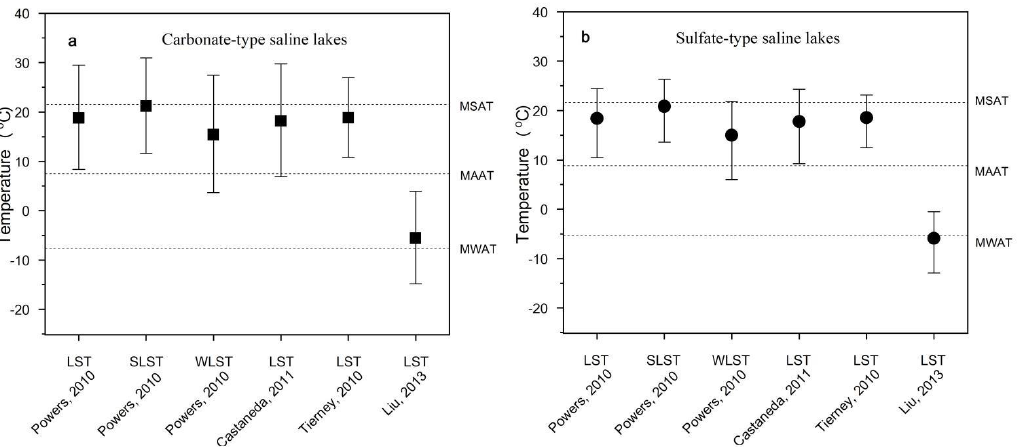
Figure 9. Comparison of reconstructed temperature based on different TEX86 calibrations as listed from formulas 14 to 19 in Table S1. ( a ): carbonate-type saline lakes and ( b ): sulfate-type saline lakes.